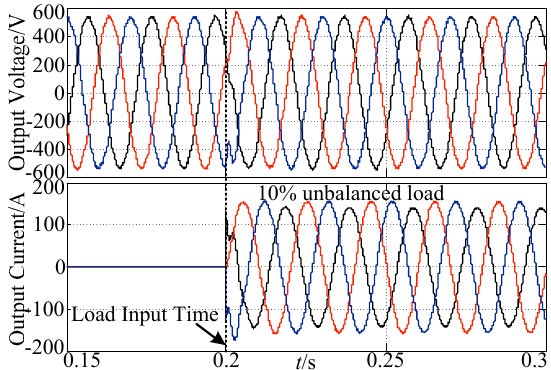
Figure 13. Simulation waveform with instantaneous unbalanced load.